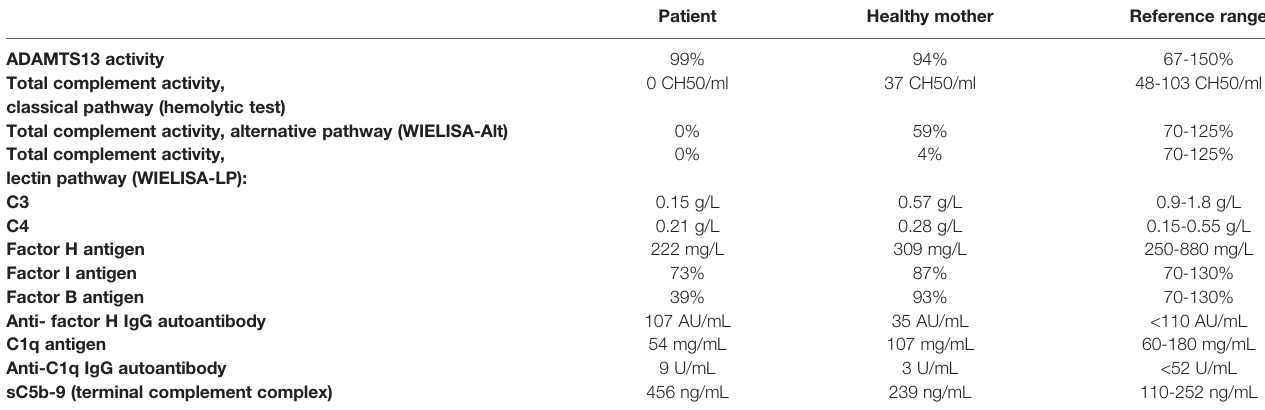
TABLE 1 | Complement pro fi le of the patient and his